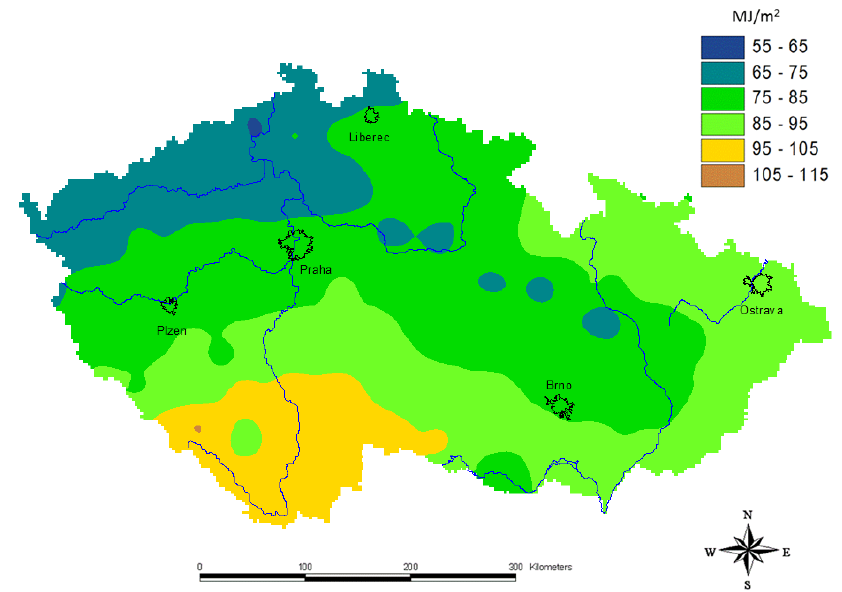
Figure 3. Monthly sum of SIS in December 2013. Example of a product combining the surface measured data and CMSAF data.